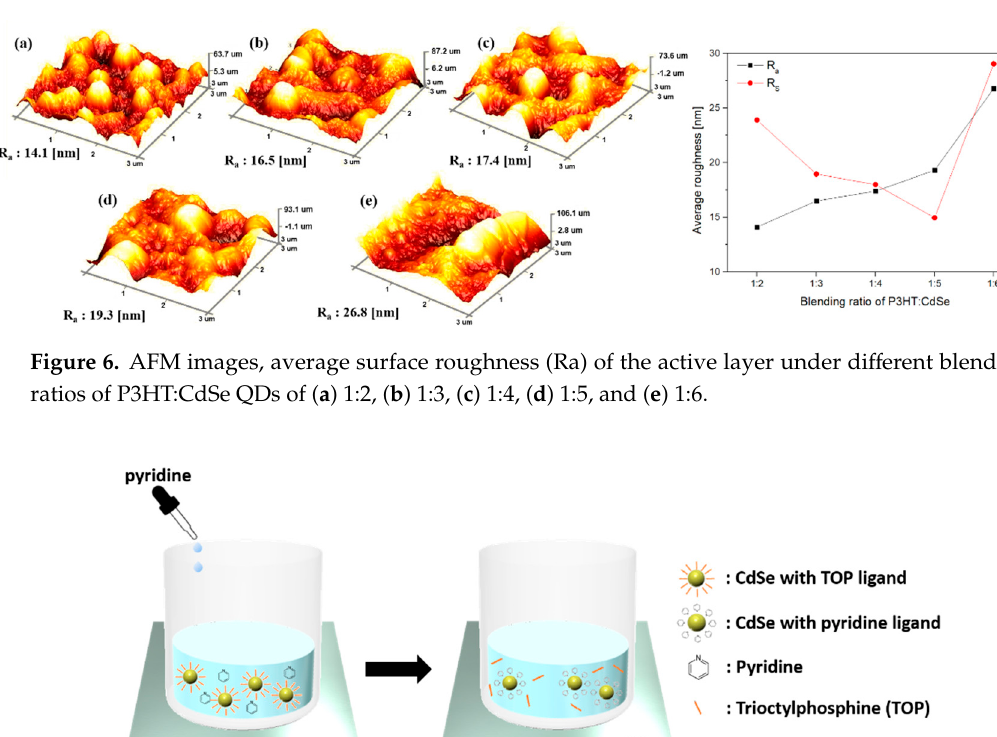
Figure 5. ( a ) The normalized solar parameters (J SC and PCE), and ( b ) radiation parameters (CCD, DCD, and sensitivity) of the detectors with different blending ratios of 1:2, 1:3, 1:4, 1:5, and 1:6 of the